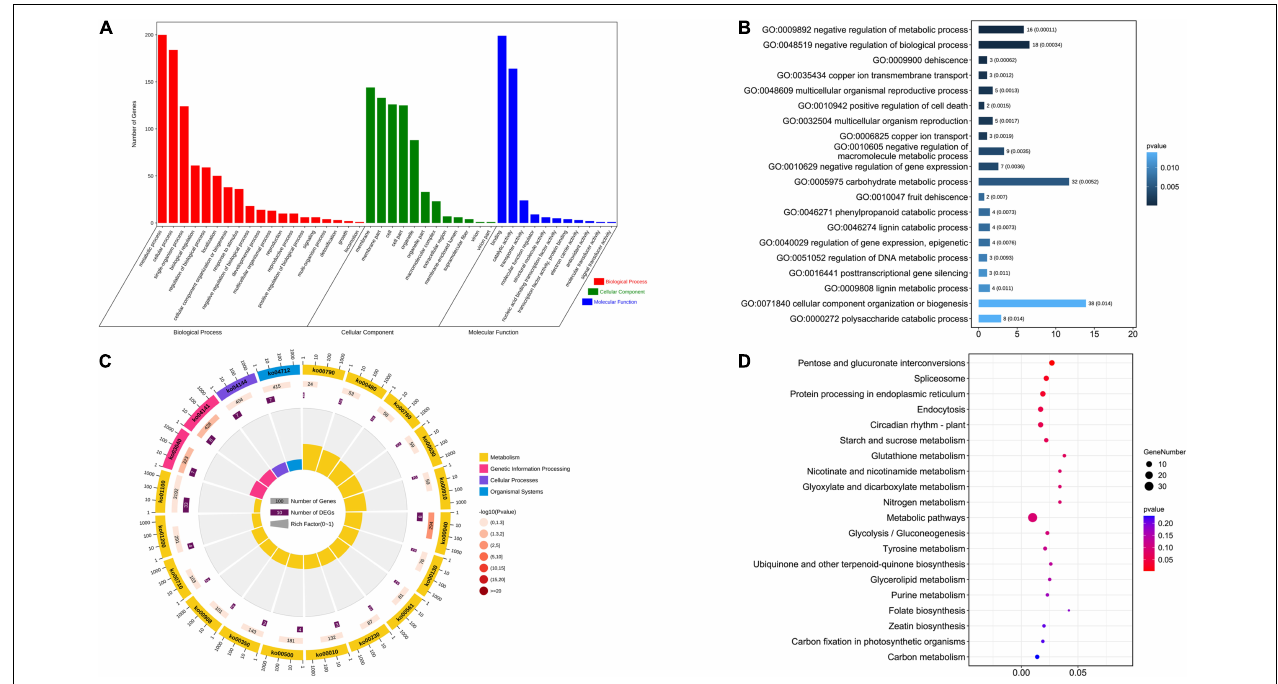
FIGURE 2 | Analysis of the GO enrichment and KEGG of stable QTLs related to seed size and shape. (A) Analysis of the GO enrichment of stable QTLs. (B) Top 20 GO terms enrichment in the molecular function category. (C) Analysis of the KEGG of stable QTLs. (D) Top 20 of KEGG enrichment.